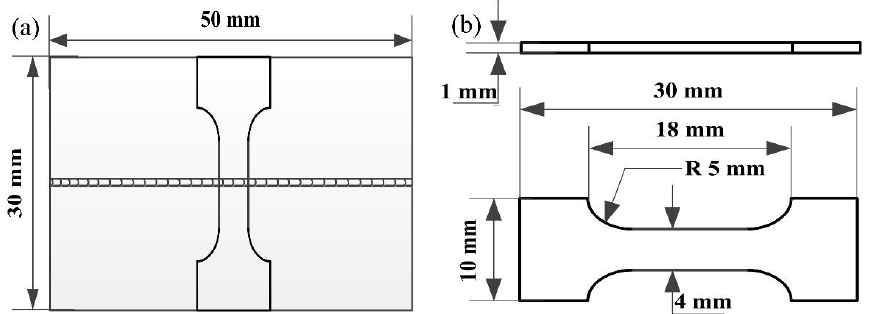
Figure 3. Schematic of the laser-welded joint ( a ) and size and shape of the tensile specimen ( b ).